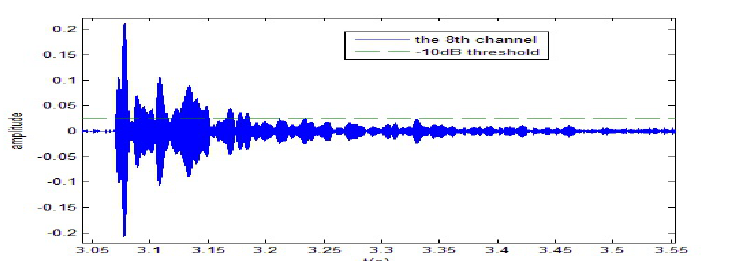
Figure 9. The probing signal at 7 kHz is received by the 8-th channel of